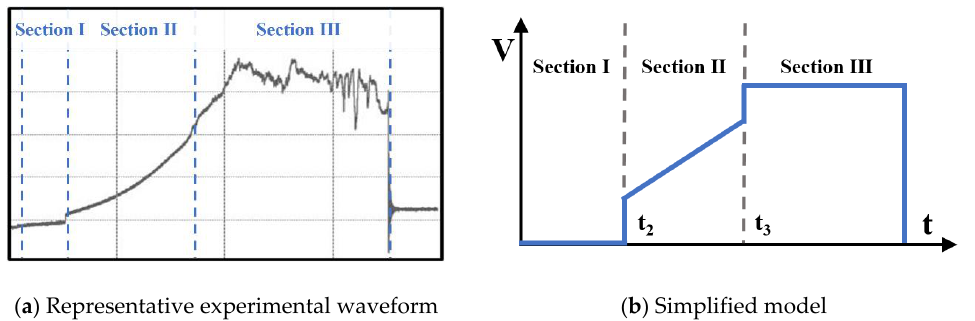
Figure 1. Molded case circuit breaker (MCCB) interruption voltage.